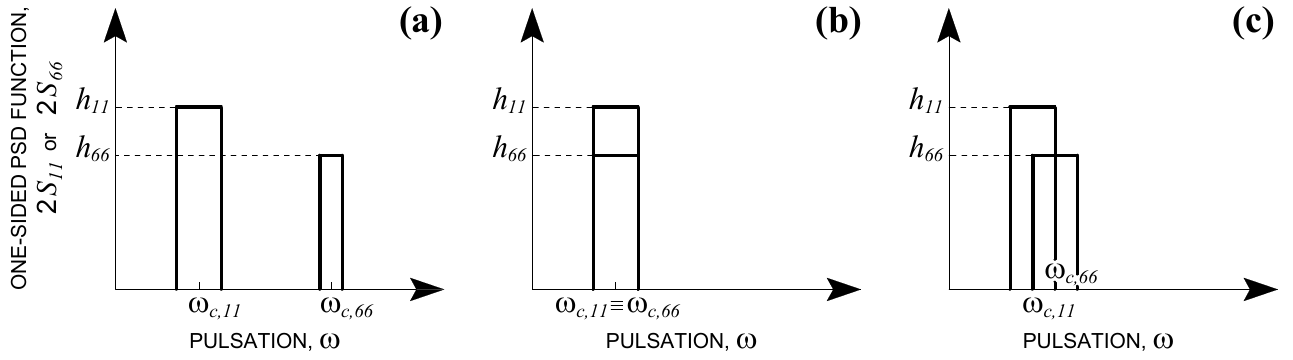
Figure 2: One-sided PSD functions: (a) totally separated spectra (i), (b) completely overlapped spectra (ii), and (c) partially overlapped spectra